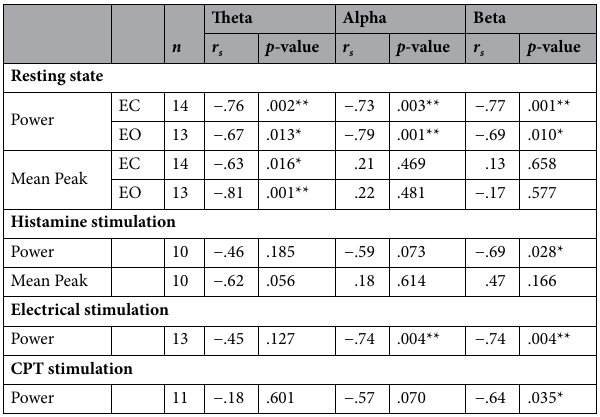
Table 3. Spearman’s correlation coefficient ( r s ) between power and mean peak frequencies during rest, with eyes closed (EC) or eyes open (EO), and stimulation states in theta, alpha, and beta bands with patients’ duration of chronic itch experience. * p < .05; ** p < .01; *** p < .001.